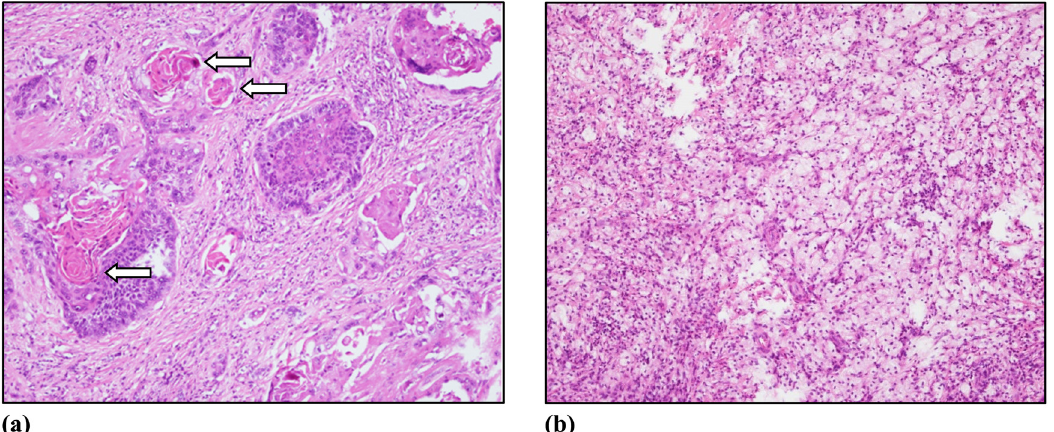
Figure 3: Hematoxylin and eosin staining. ( a ) Moderately di ff erentiated squamous cell carcinoma ( SCC ) with keratin deposition and pearl formation ( white arrows ) . ( b ) The parenchyma shows a focal area of foamy histiocytes with giant cells, lymphocytic in fi ltration and fi brocollagenous tissue, which is suggestive of